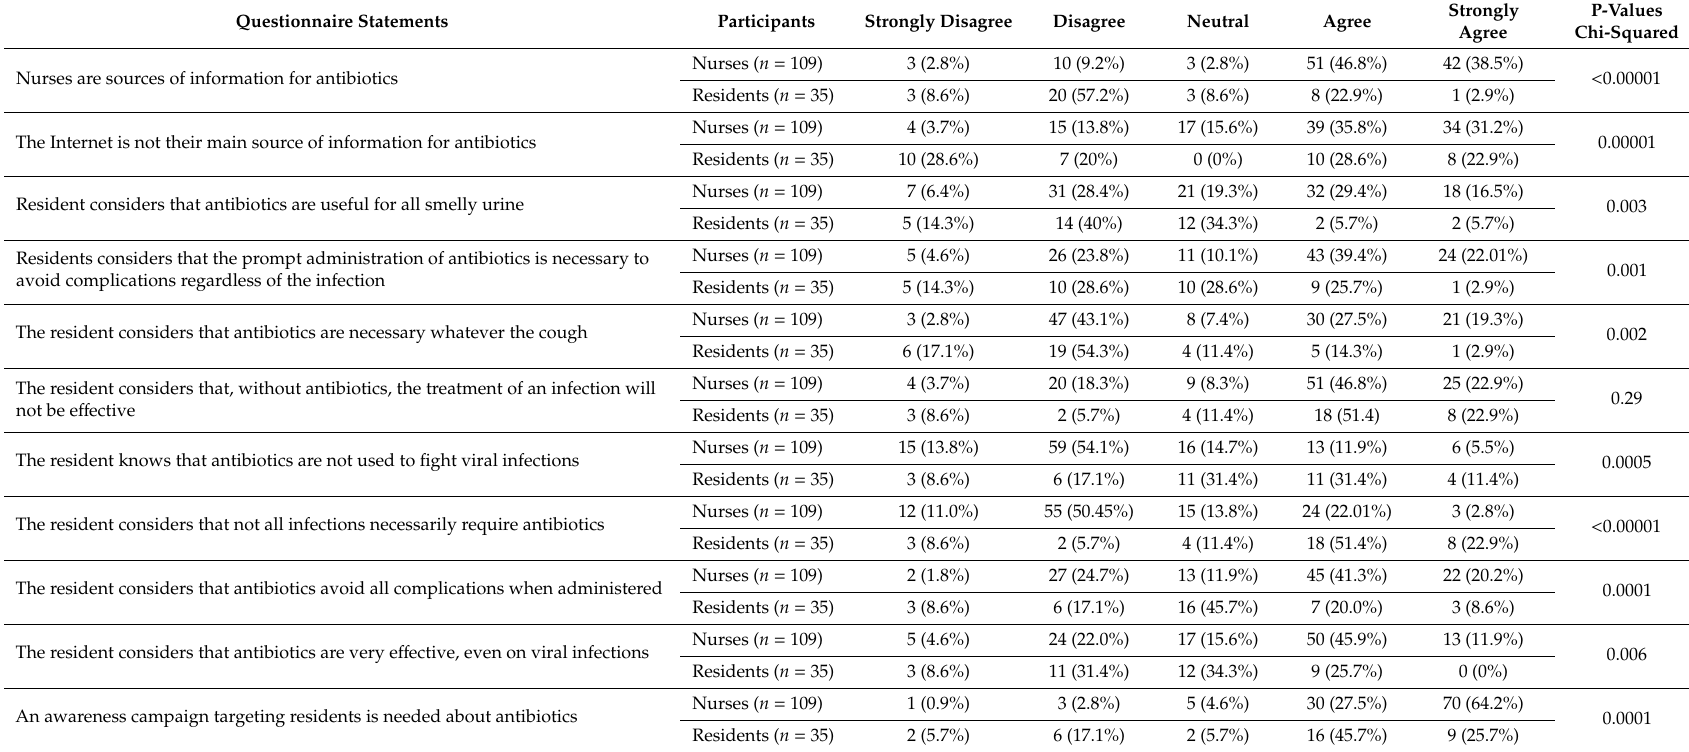
Table 2. Residents’ and nurses’